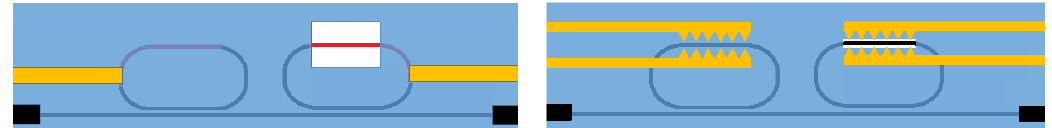
Figure 7. Ring resonator layout. Each sensor consists of two ring resonators (dark blue) coupled to a common bus waveguide (dark blue) using directional couplers. One ring is completely covered with SiO2 (light blue) and acts as a reference to control for ambient temperature. The two variants differ in terms of using doped waveguides (left) and coplanar electrodes (right) for dielectrophoresis. Two grating couplers at the ends of the bus waveguide allow for coupling to fiber optics. A racetrack-like ring geometry with two 90 µ m straight segments parallel to the bus function as a directional coupler and sensing area, respectively; a 20 µ m straight segment vertical to the bus allows ◦ for electrical contact with the waveguide; and four 90 bends (radius of 55 µ m) connect the straight segments. A straight sensor area was chosen, as it allows for a straightforward way of placing